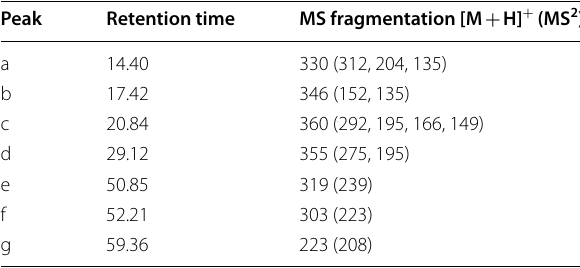
Table 3 MS fragmentation of 7 common